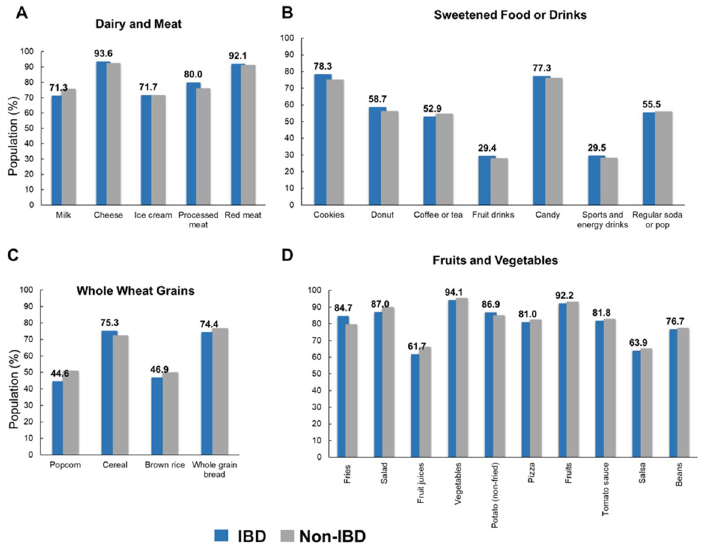
Fig 3. Comparison of weighted proportion of food intake between estimated US population with IBD and without IBD, NHIS 2015. Values in panels A, B, C, and D reflect those of IBD population. � Asterisks indicate statistically significant difference (p-value < 0.05) when compared to estimated non-IBD population.